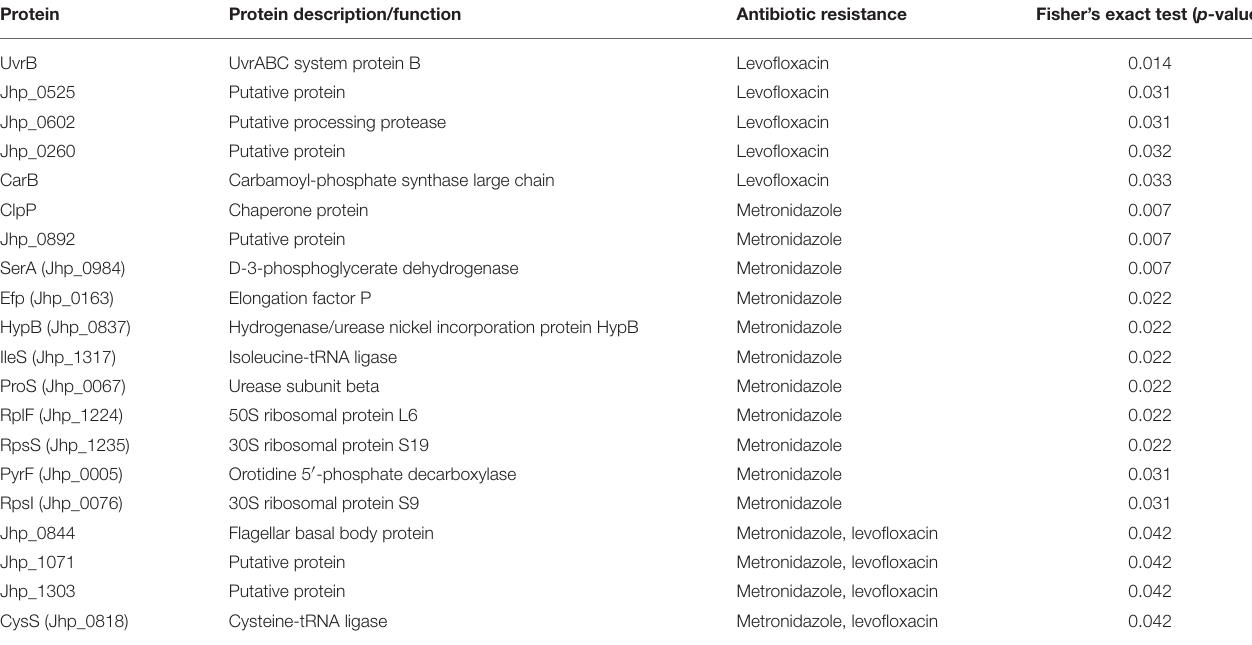
TABLE 4 | Proteins of significant association with resistance to metronidazole, levofloxacin, and/or clarithromycin in all of the 18 H. pylori strains tested using Fisher’s exact test (2-tailed, p < 0.05 is considered significant). Protein